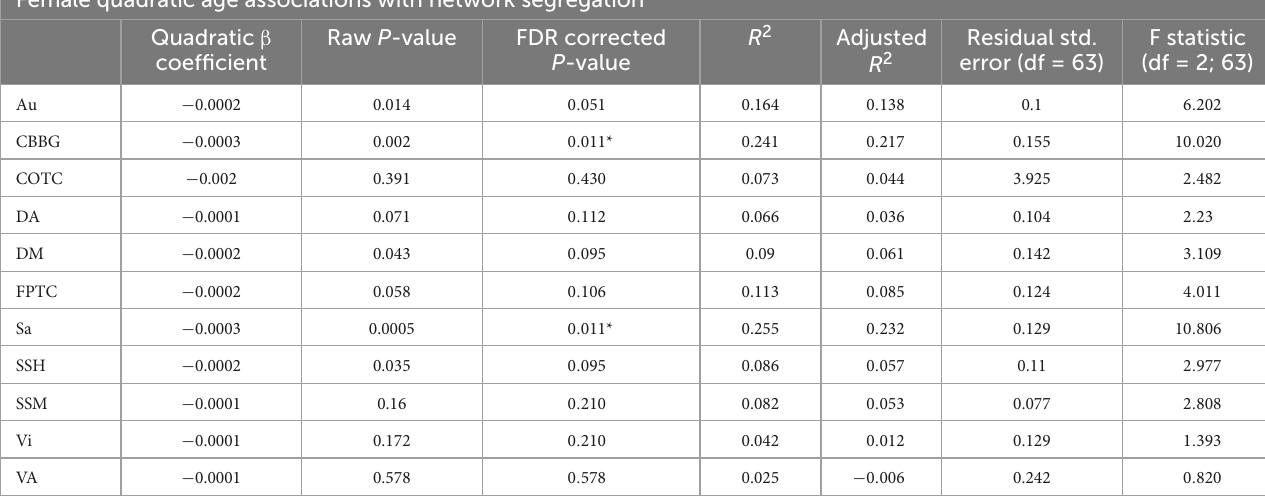
Raw p -valuesandFDRcorrected p -valuesareincluded.TherewerenosignificantfindingsafterFDRcorrection. TABLE 7 This table exhibits results from quadratic regressions for age and network segregation in females. Female quadratic age associations with network